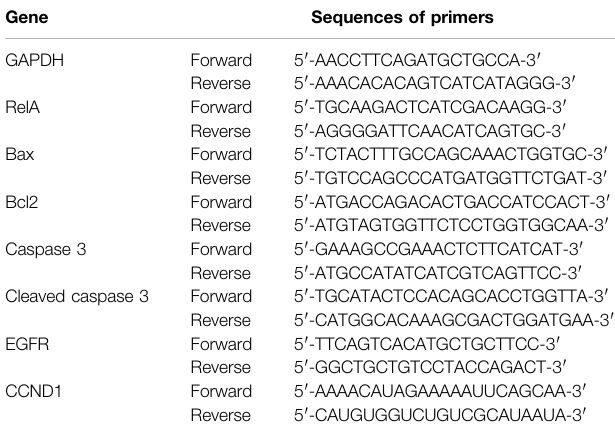
TABLE 1 | qPCR primer sequence list of related